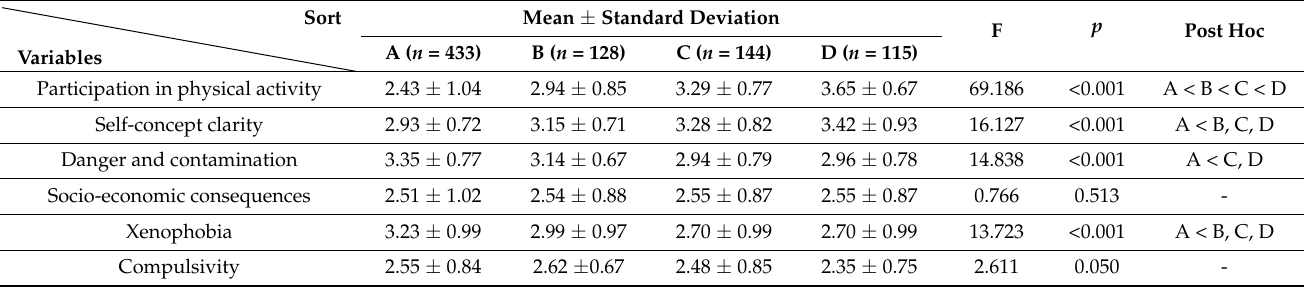
Table 9. Differences in each variable according to frequency of physical